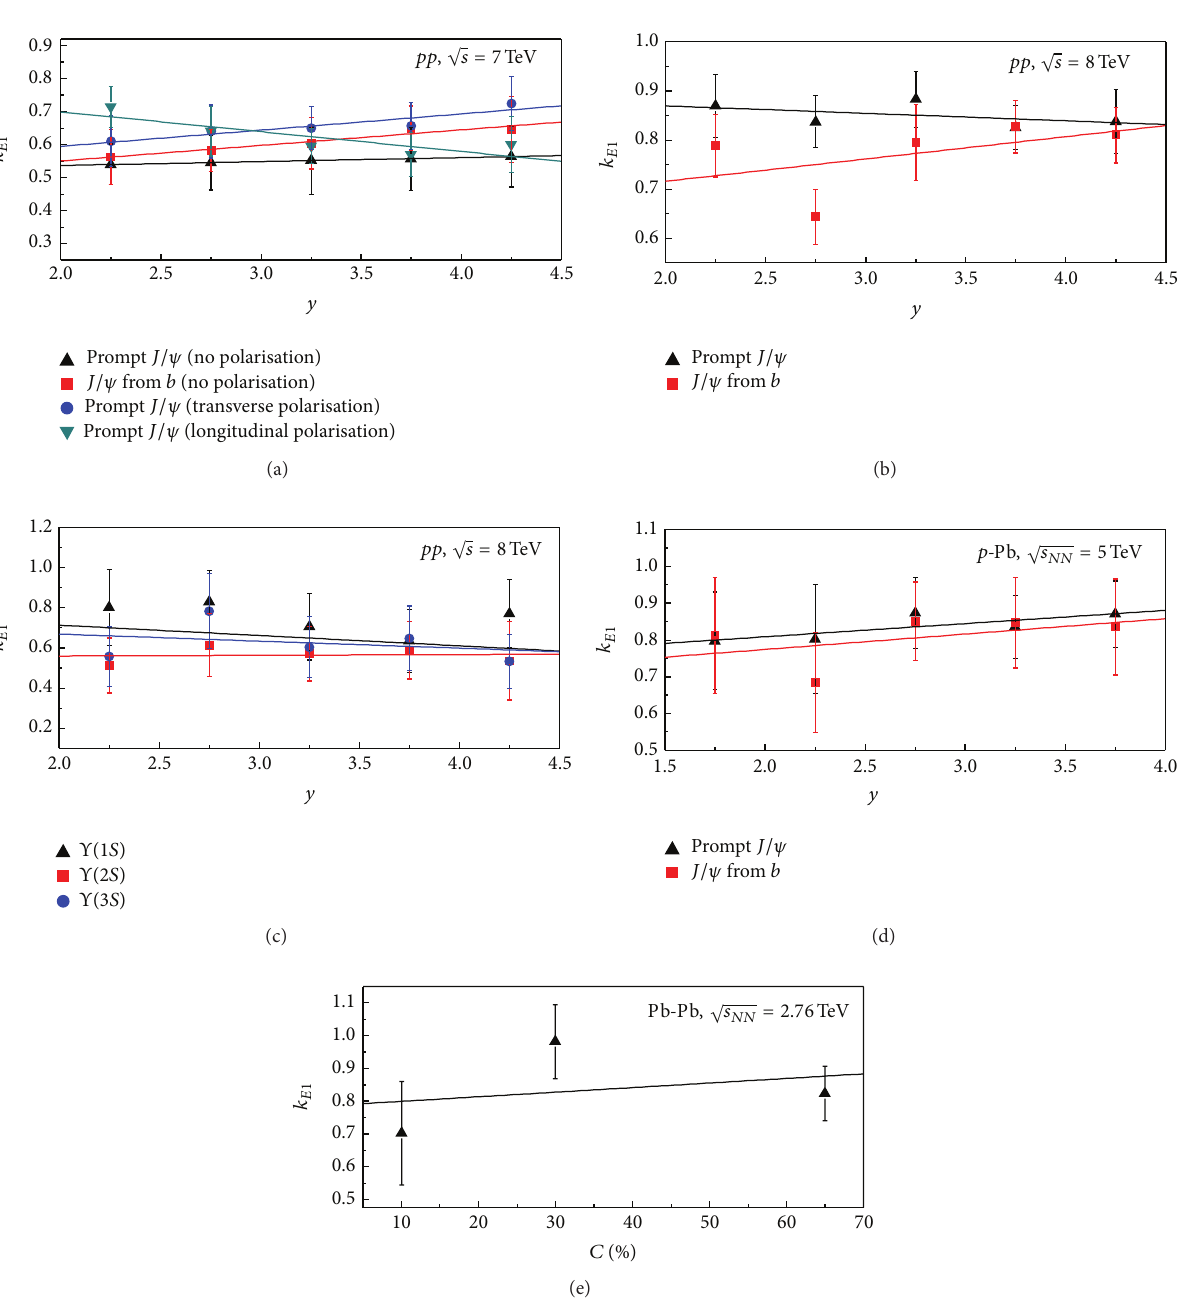
Figure 6: Dependence of contribution ratio 𝑘 𝐸1 for (a) 𝐽/𝜓 on 𝑦 in 𝑝𝑝 collision at √𝑠 = 7 TeV, (b) 𝐽/𝜓 on 𝑦 in 𝑝𝑝 collision at √𝑠 = 8 TeV, (c) Υ on 𝑦 in 𝑝𝑝 collision at √𝑠 = 8 TeV, (d) 𝐽/𝜓 on 𝑦 in 𝑝 -Pb collisions at √𝑠 𝑁𝑁 = 5 TeV, and (e) 𝐽/𝜓 on 𝐶 in Pb-Pb collisions at √𝑠 𝑁𝑁 = 2.76 TeV. The symbols are quoted in Table 1 and the lines are our fitting